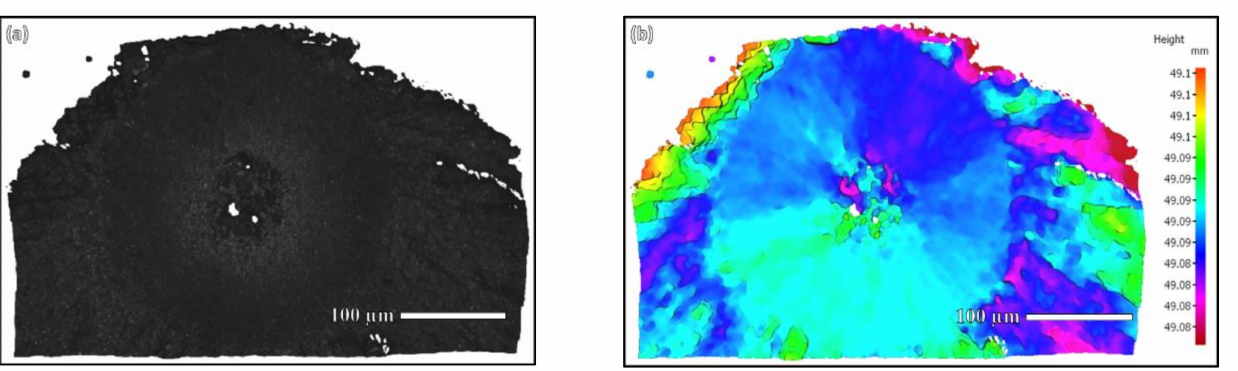
Figure 9. 3D morphology scanning of fish-eye region: ( a ) scanning area of the fish-eye zone; ( b ) 3D contour of the fish-eye zone. The fish-eye zone is relatively flat compared to the outside crack propagation